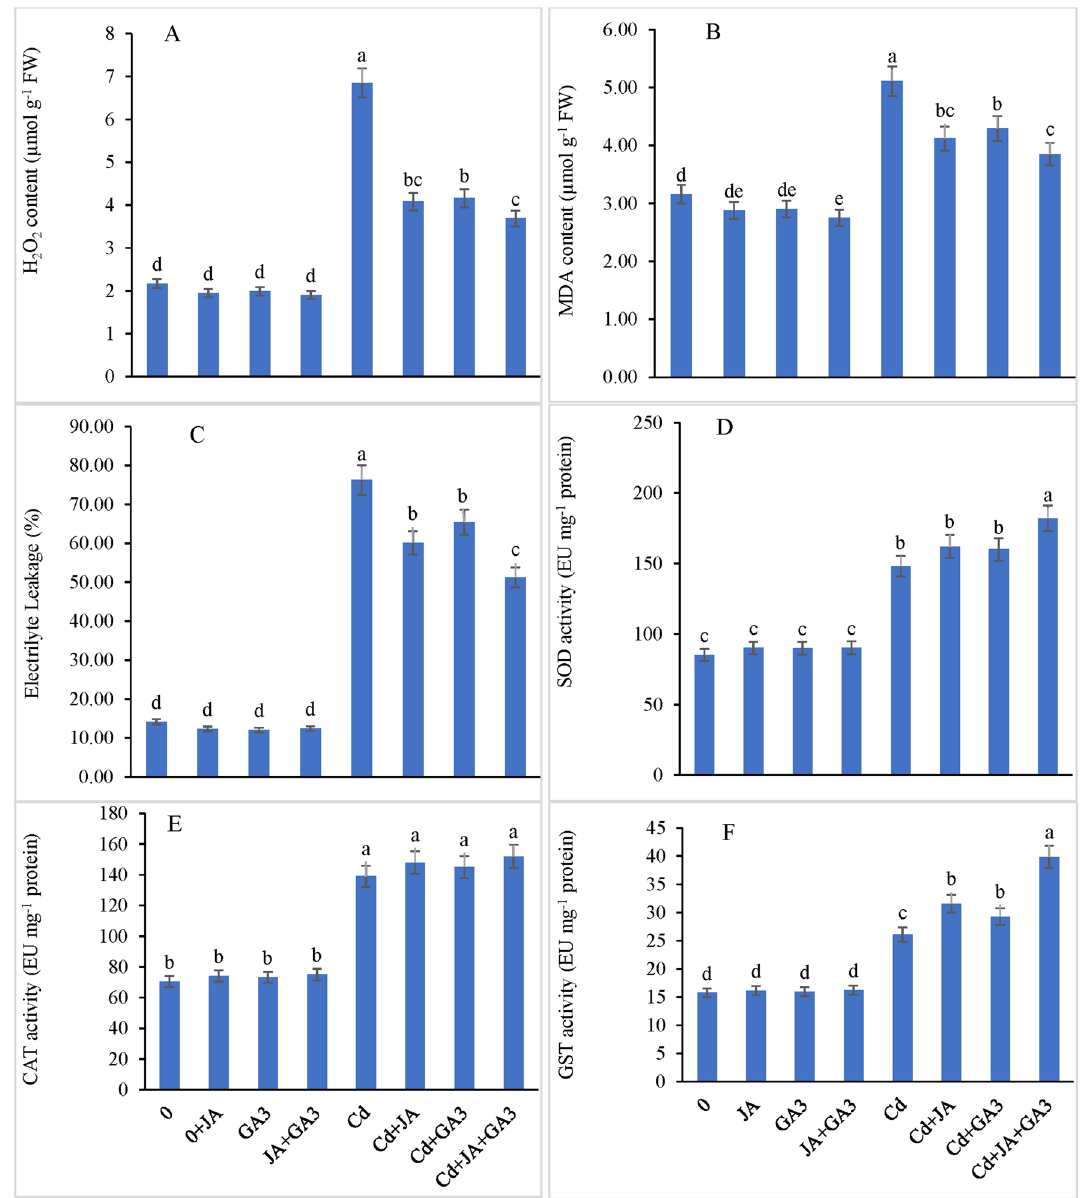
Figure 3. Effect of JA and GA 3 applied individually or in combination decreased the oxidative stress biomarkers, ( A ) H 2 O 2 : hydrogen peroxide content, ( B ) MDA: malondialdehyde content, ( C ) EL: electrolyte leakage, ( D ) SOD: superoxide dismutase, ( E ) CAT: catalase and ( F ) GST: glutathione- S -transferase in Cd-stressed chickpea plants (Mean ± 7.69% in DHAR and MDHAR activity, respectively, compared to the respective controls. From the analysis of variance of the data for all the afore-mentioned enzymes, it is evident that both PGRs functioned synergistically (Interaction term JA + GA 3 + Cd, P ≤ 0.001) to modulate the activities of these enzymes under Cd toxicity. JA maintained the contents of ascorbic Acid (AsA), GSH, and GSSG, and GSH/GSSG ratio. During normal growth conditions, no significant effect of JA and GA 3 was recorded on AsA levels. The AsA levels showed a sharp decline by 59.18% relative to the control when the plants were subjected to cadmium stress (Fig. 4E). Fur- thermore, the AsA levels further increased in the cadmium treated plants when supplemented with JA and GA 3 either alone or in combination. However, the combined treatment of JA + GA 3 showed a maximal enhancement in AsA levels by 65% in the plants subjected to Cd stress relative to those of Cd-alone treated plants. An increase of 63.47% was observed in GSH concentration in the plants under Cd stress, relative to the control (Fig. 4F). Jasmonic acid pre-treatment and foliar supplementation of GA 3 to the Cd-stressed pants showed a further esca- lation in GSH content by 6.38% and 19.68%, respectively, compared with the controls. Further, the Cd affected